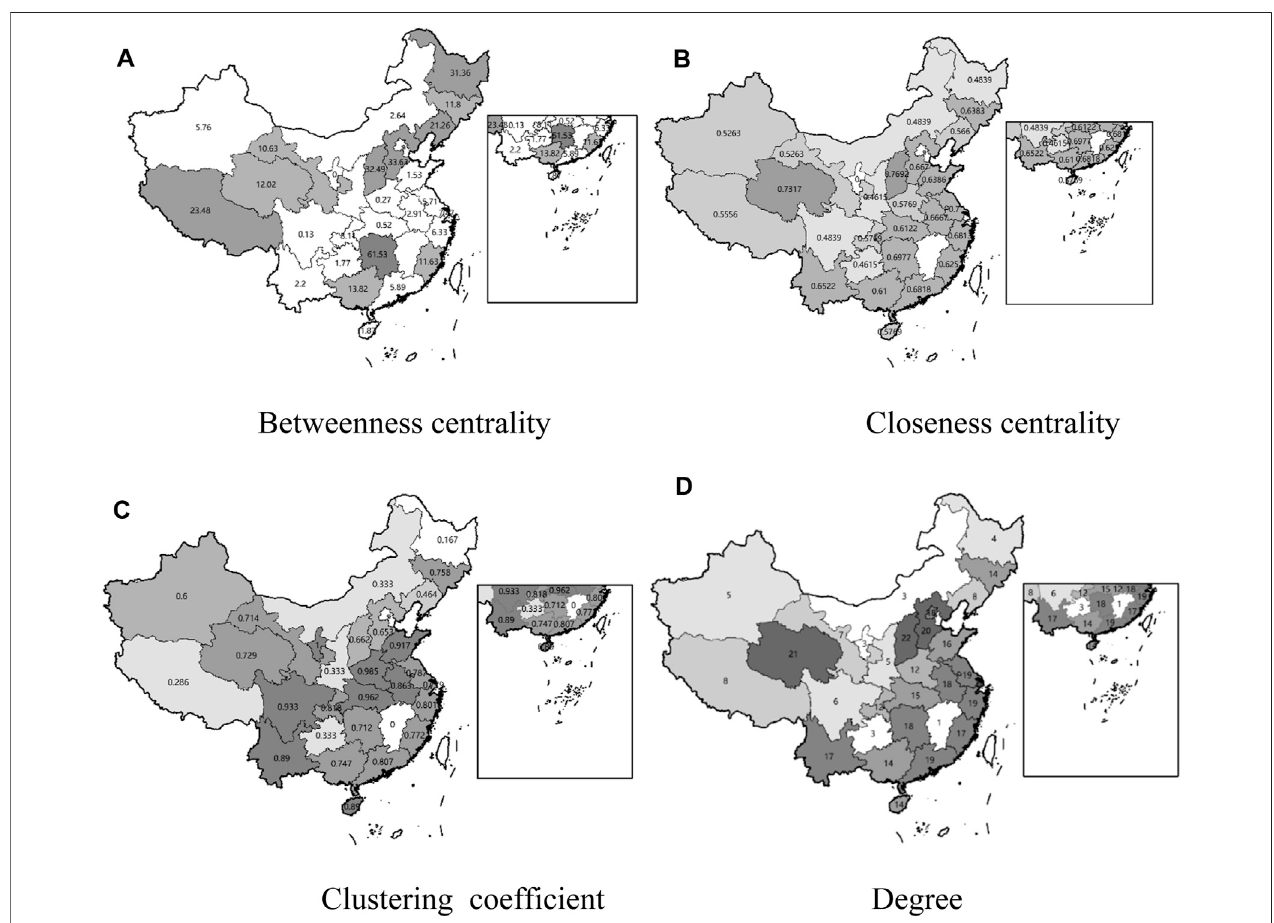
FIGURE 7 | (A) Betweenness centrality, (B) closeness centrality, (C) clustering, and (D) degree of centrality for all provinces in China.